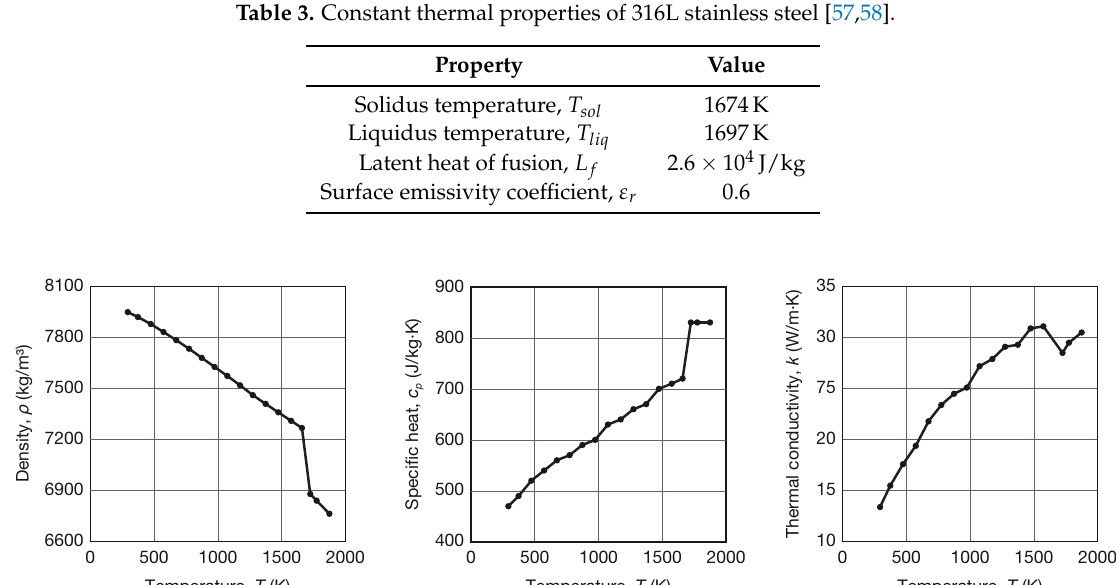
Figure 6. Temperature dependent thermal properties of 316L stainless steel